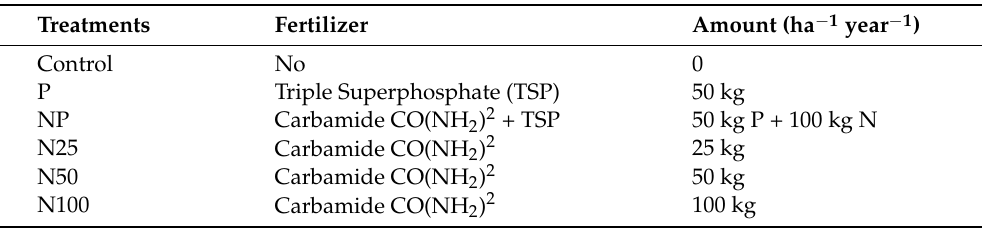
Table 1. Design of the nutrient addition experiment on the alpine grassland since 2012 (N: nitrogen, P: